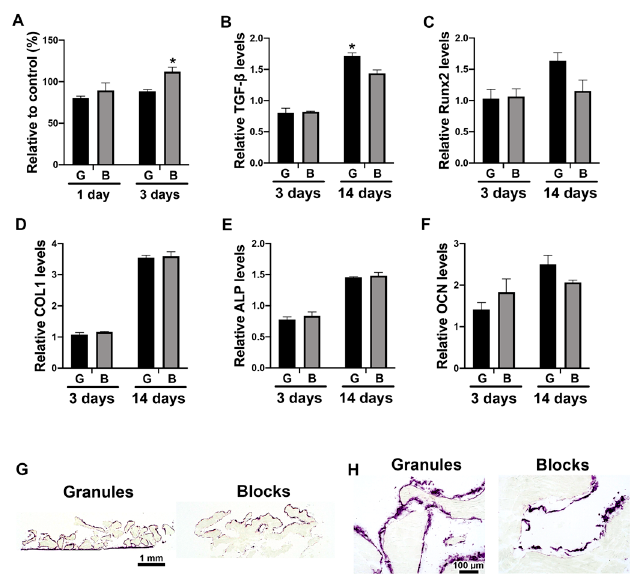
Figure 2. Osteoblast differentiation on DBBM granules or blocks. ( A ) Viability assay of Saos-2 cells cultured on DBBM granules (shown as “G”) or blocks (shown as “B”) at days 1 and 3. (*Denotes significantly higher than the other group, p < 0.05). ( B–F ) Real-time PCR of Saos-2 cells seeded on DBBM granules or blocks for genes encoding ( B ) TGF- β , ( C ) Runx 2, ( D ) COL1, ( E ) ALP, and ( F ) OCN at days 3 and 14 after cell seeding. (* Denotes significantly higher than the other group, p < 0.05). ( G, H ) ALP staining of undecalcified frozen sections of Saos-2 cells cultured on DBBM granules or blocks for 14 days. The violet-stained cells demonstrate ALP activity. (Original magnification ( G ) 50 × , ( H ) 500 × ).